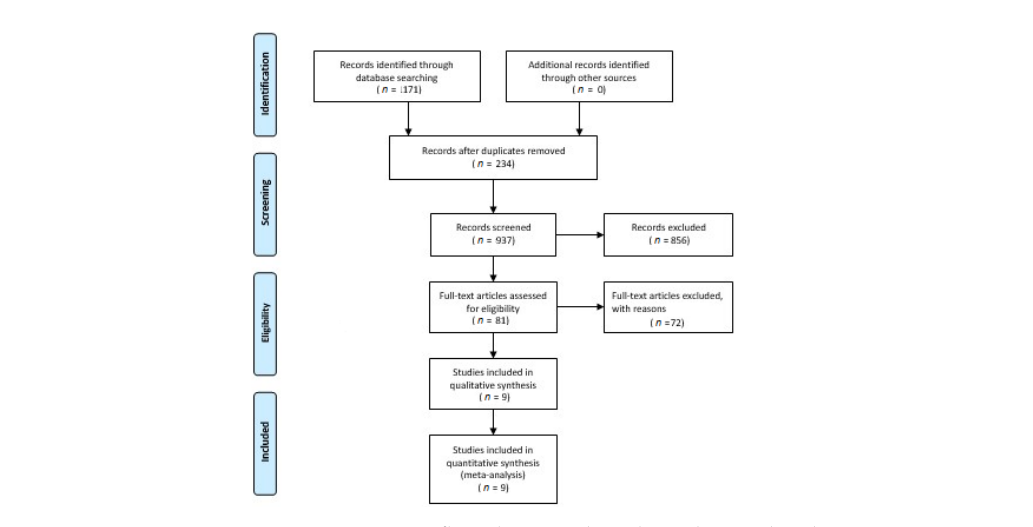
Figure 1. PRISMA flow diagram describing the article selection process. Table 1. Characteristics of eligible studies.